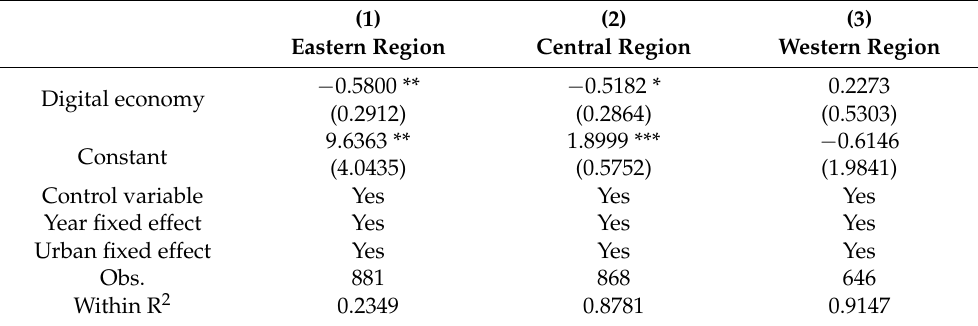
Table 6. Regression results of urban samples in eastern, central and western